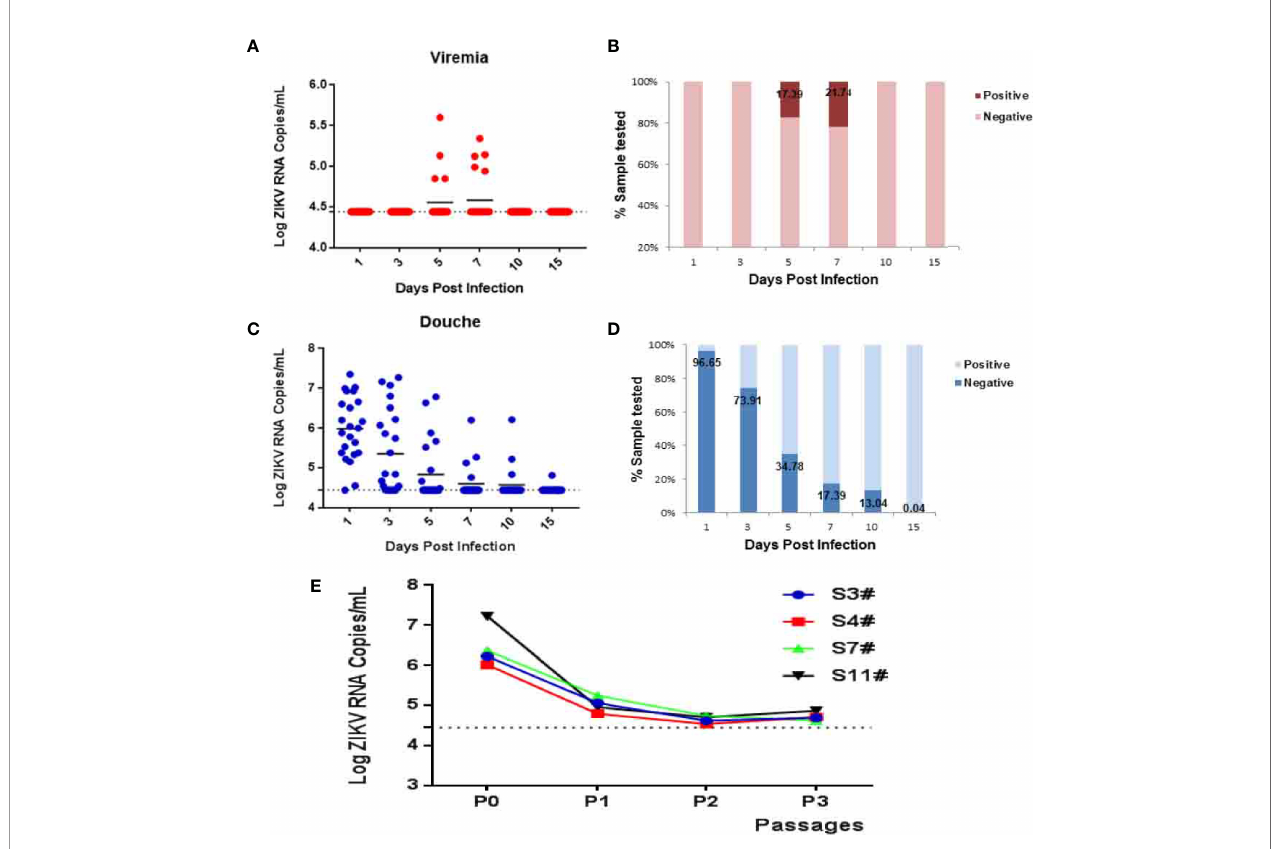
FIGURE 2 | ZIKV establishes systemic infection in tree shrews infected via vaginal inoculation. Viral loads in blood and vaginal douching were determined by RT-qPCR. (A, B) The kinetics and time courses of viremia in blood of ZIKV-infected tree shrews. (C, D) The kinetics and time courses of the viral load in vaginal douching of infected tree shrews. The detection limit is indicated by the dotted line. (E) C6/36 cell were used to isolate the virus from the douche of ZIKV infected tree shrews 1 dpi. The symbol “ # ” means